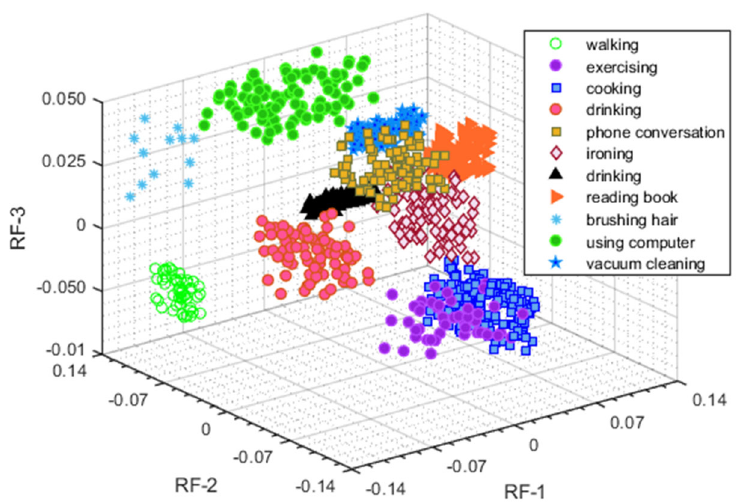
Figure 8. Proposed HPAR model from the random forest classifier.